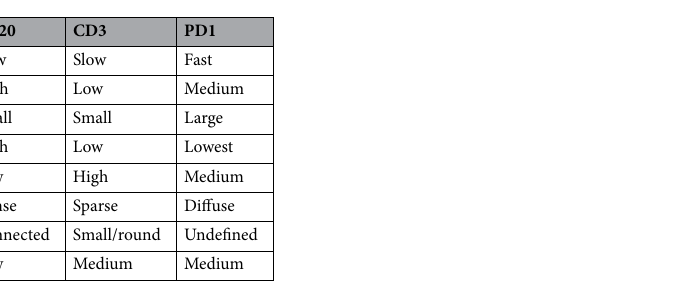
Table 2. Short qualitative description of considered cell types in terms of most likely (prototypical) properties given at different levels of